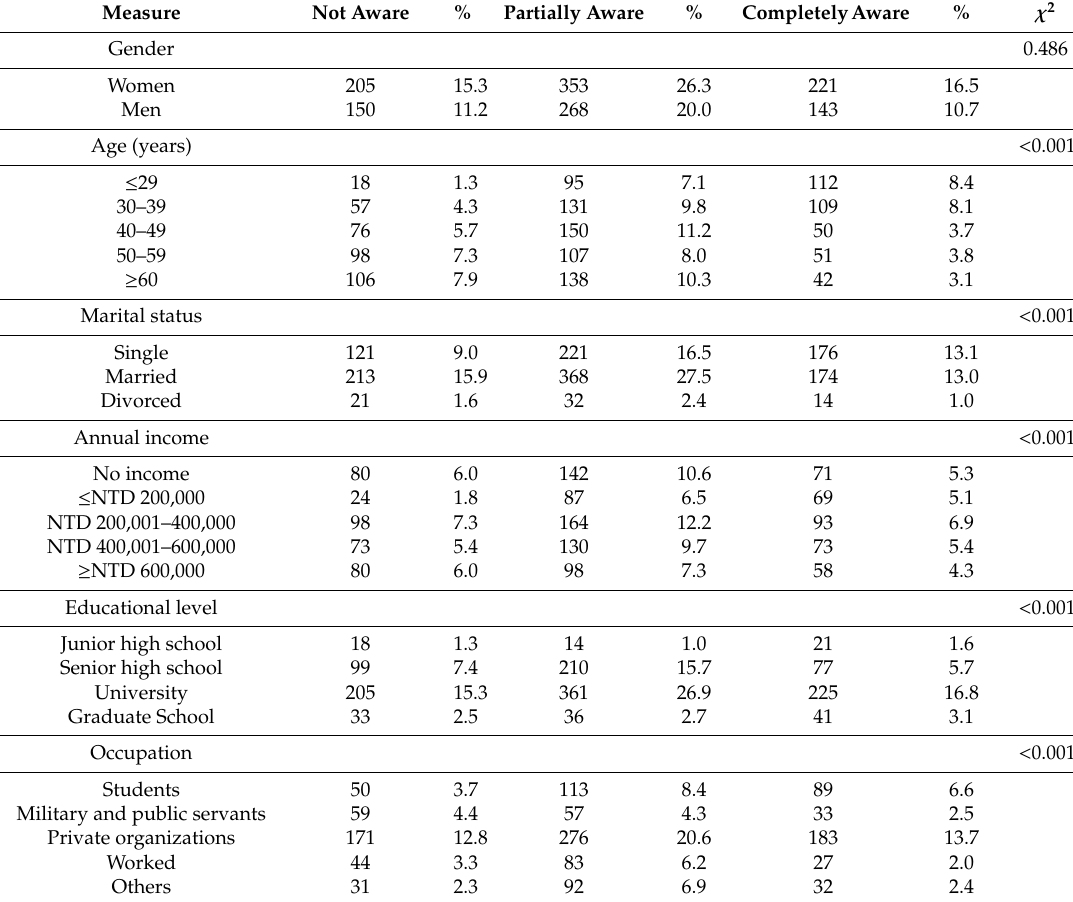
Table 1. Relation of the hierarchical medical system and reduce outpatient visits to basic participant variables ( N =